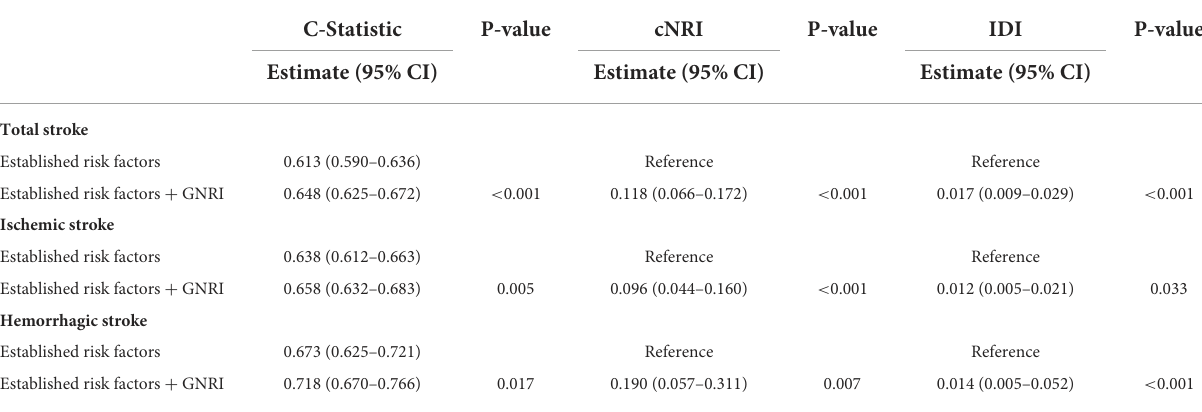
TABLE 3 Incremental predictive value of